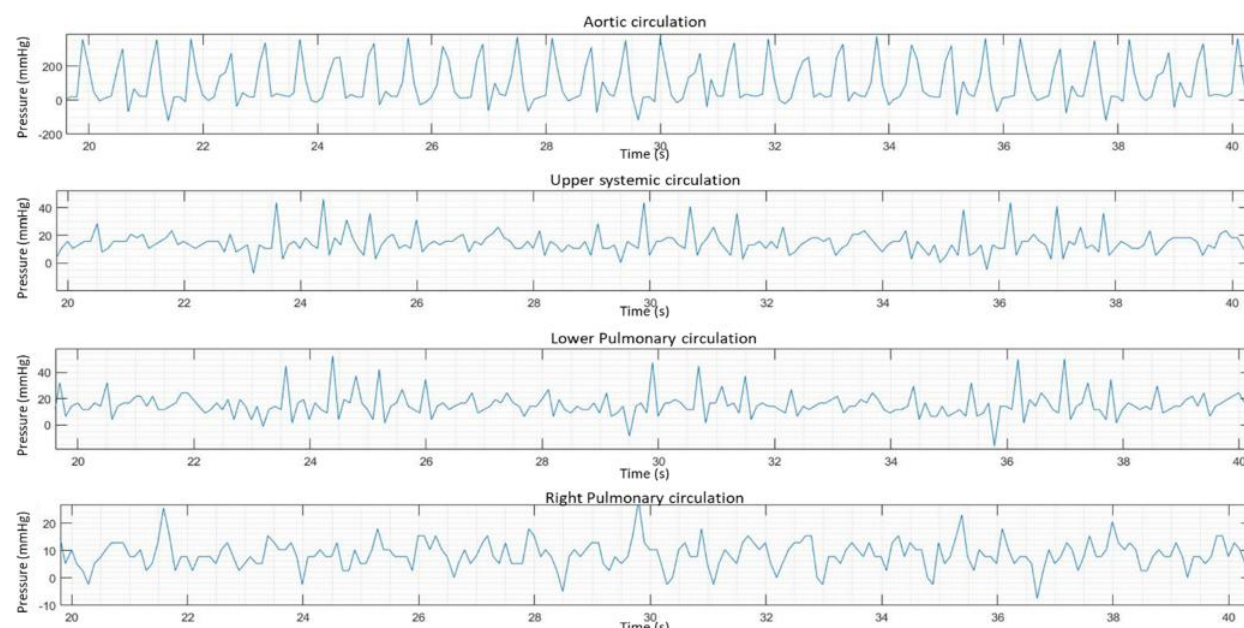
Figure 11. Unfiltered Flow waveform for 3 mm IJS experiment.